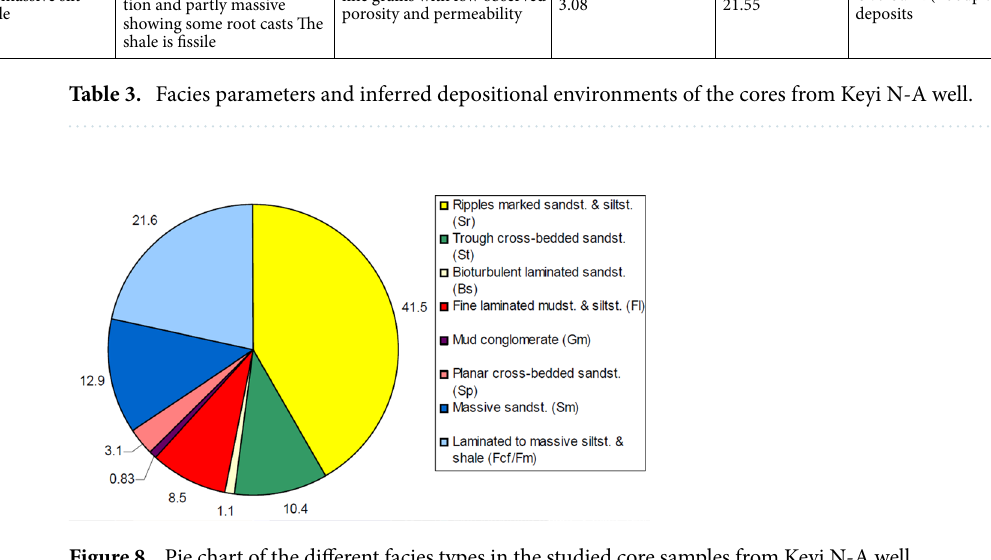
Figure 8. Pie chart of the different facies types in the studied core samples from Keyi N-A